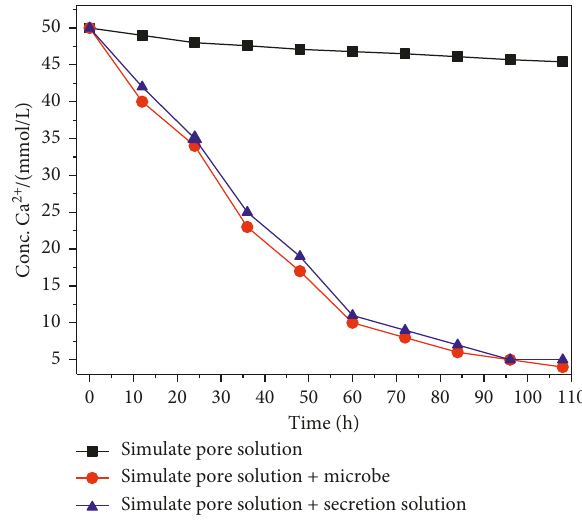
Figure 4: Change of Ca 2+ concentration with time.